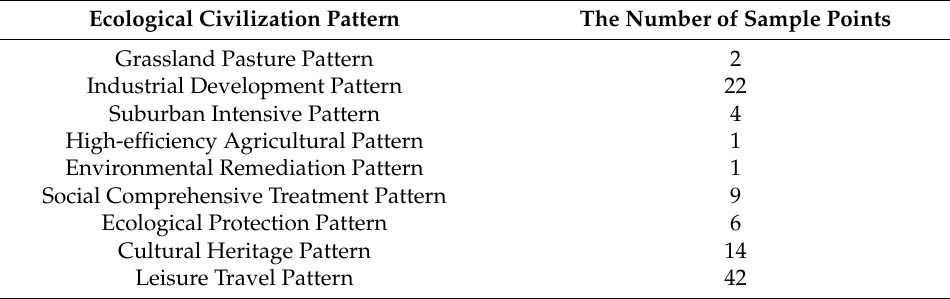
Table 4. Number of sample points under a rural ecological civilization pattern. Ecological Civilization Pattern